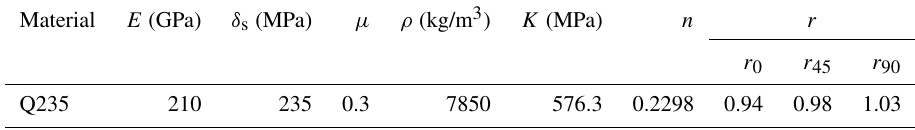
Table 1. Mechanical properties of the Q235